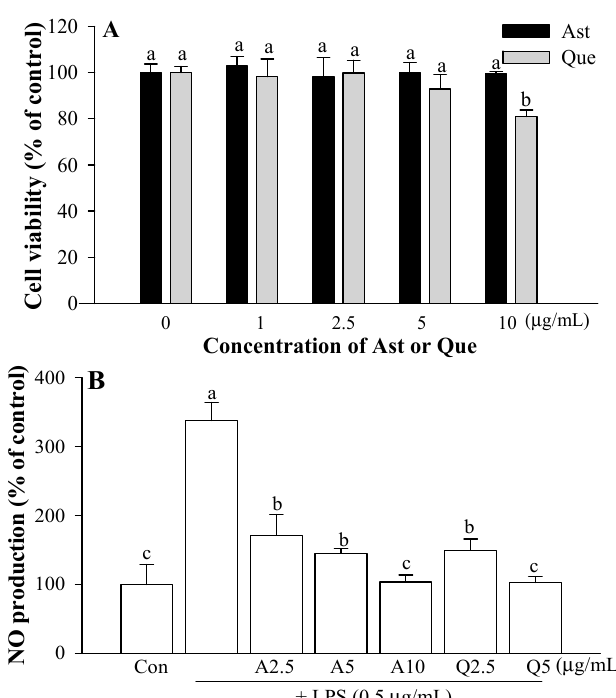
Figure 3. Effect of Ast and Que on ( A ) the cell viability of microglia and ( B ) NO production in LPS- activated microglia. Con, control: LPS- and sample-untreated cells; Group LPS: cell treated with LPS only. The values shown are the mean ± standard deviation (SD) ( n = 3) and mean labelled with different letters (a–c) within a property differ significantly from each other by Duncan’s multiple range test ( p < 0.05).